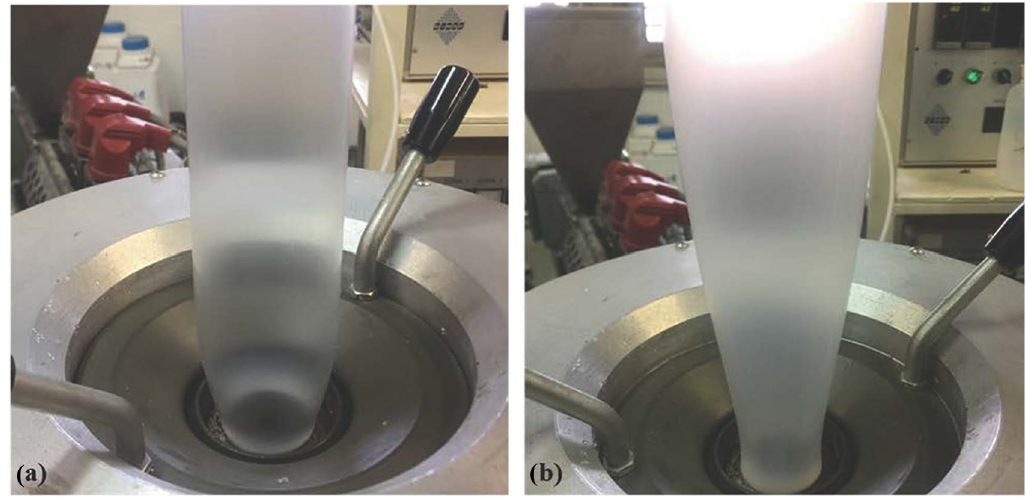
Figure 2. Films of PLA40 produced ( a ) with and ( b ) without bubble